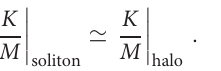
2 in the case of a ψ = | | r s . At larger distances the difference grows = r 2 ) and large radii ( r 1 / 2 ), ∼ ∼